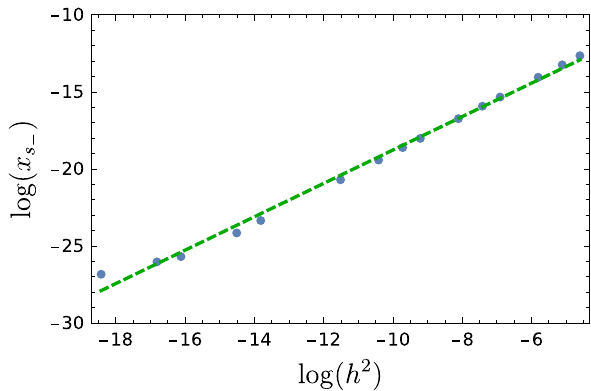
/ h 2 as a function of h 2 for P = 1 / 2 and ξ = 10. Fig. 8 The ratio x 2 2 0 Fig. 10 Measure of the singular region due to the presence of the fixed The solid line represents the numerical solution from the shooting from the minimum whereas the dashed line represents the analytic solution, singularity in x = 0 as a function of h 2 . The with is estimated by which can be found in Eq. (84) the criteria f (cid:10)(cid:10) ( x s − ) = 4. For fixed ξ 2 = 10 we have found that the numerical points are well approximated by the power law (dashed line) x s − ∼ h 2 a where a (cid:16) 1 .